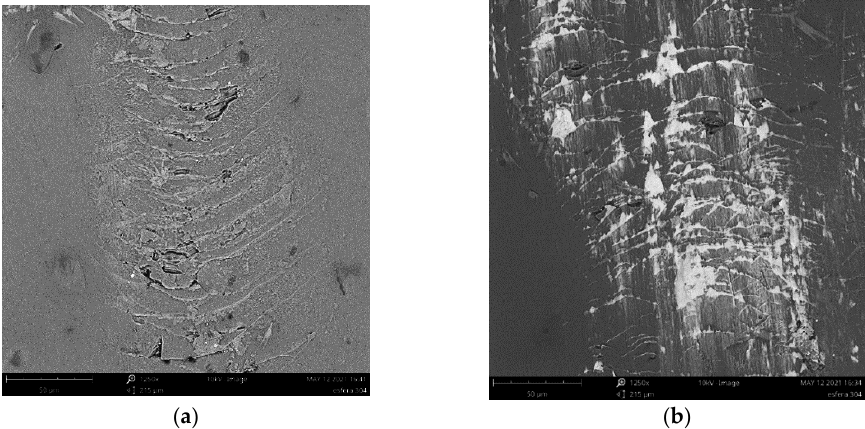
Figure 14. Cracks and metal deposition on glazed surface with ( a ) hard AISI420 steel and ( b ) soft AISI304 steel balls.